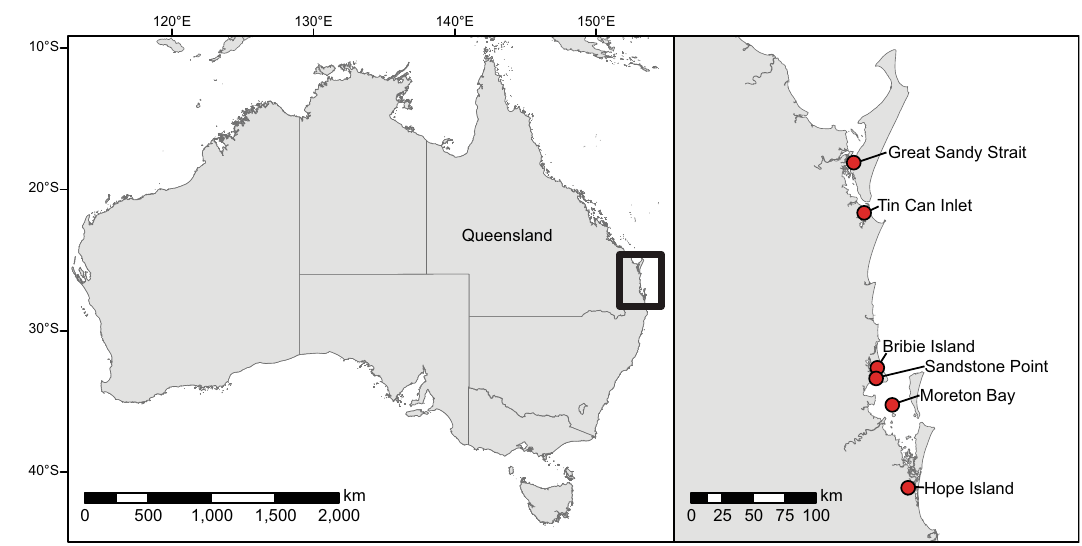
Fig. 6 Map of Australian study area, Southeast Queensland. Locations of oyster-bearing sites correspond to site locations in the Supplementary